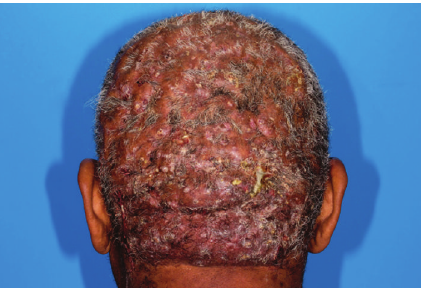
Figure 1: Preoperative appearance of the patient’s diseased scalp showingmultipledischargingpustules,diffusealopecia,andfibrosis.